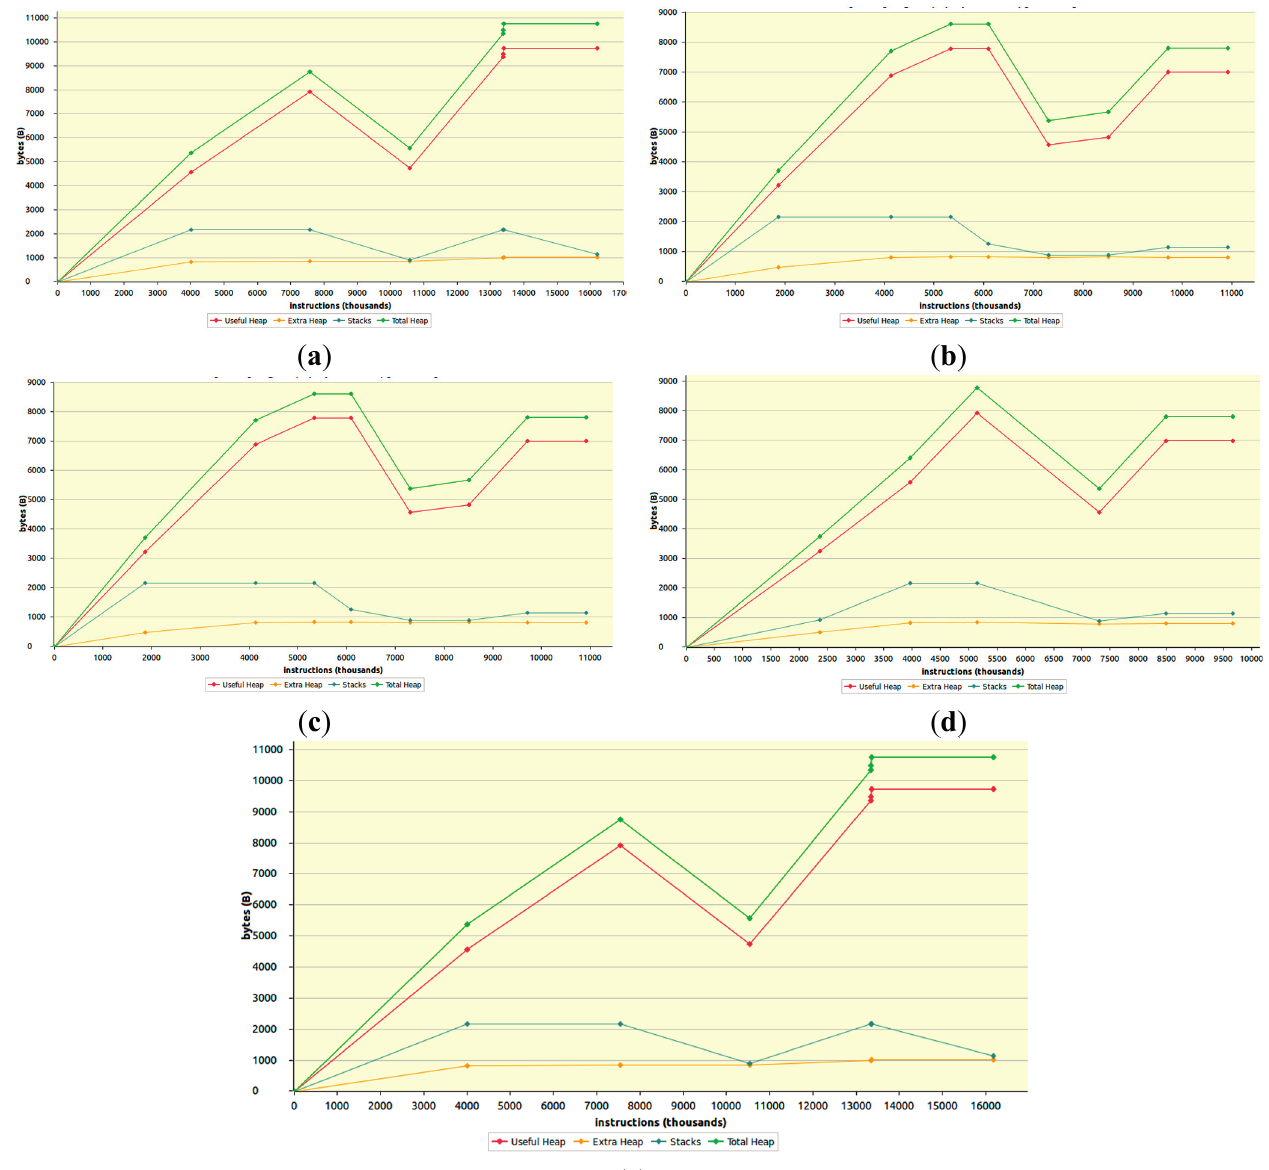
Figure 8. RAM consumption for ICMetric based symmetric key variants ( a ) 160-bit; ( b ) 224-bit; ( c ) 256-bit; ( d ) 384-bit; ( e )